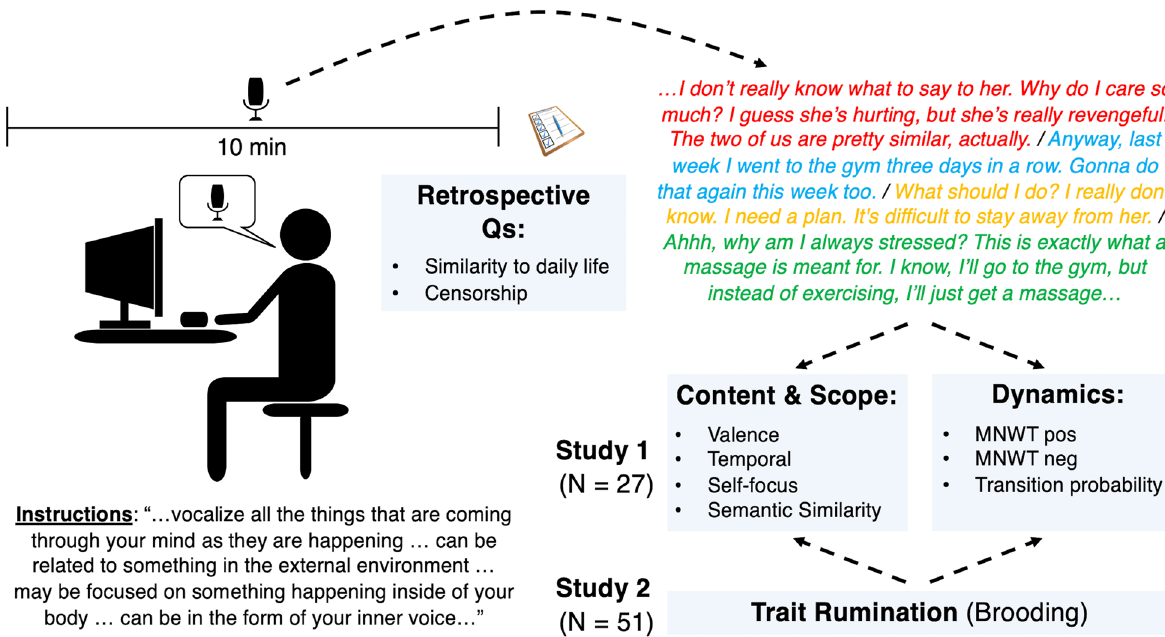
Figure 1. Think aloud paradigm. Participants were audio recorded while voicing aloud their unprompted thoughts for 10 min. Audio recordings were transcribed and coded by hand or automated text analysis for content and dynamics. These indices were explored as predictors of individual differences in trait brooding. MNWT: Mean number of words per